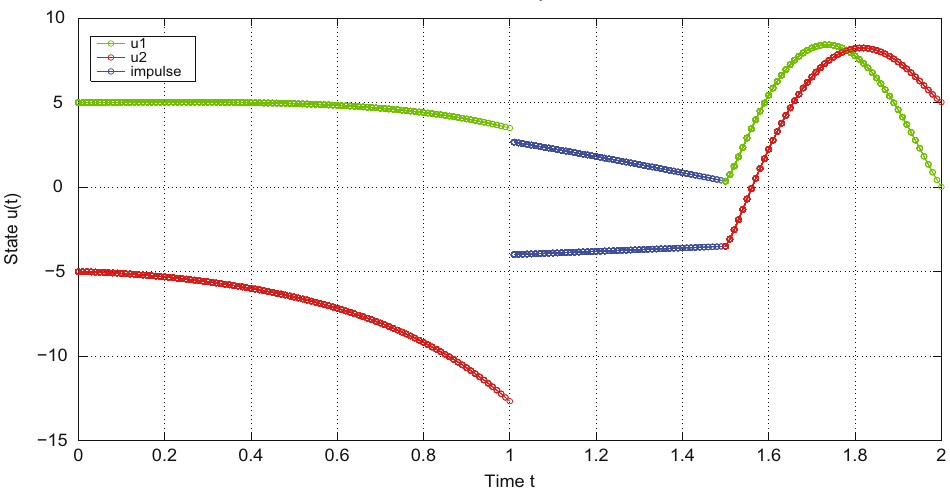
5   and reaches the fi nal   − 5